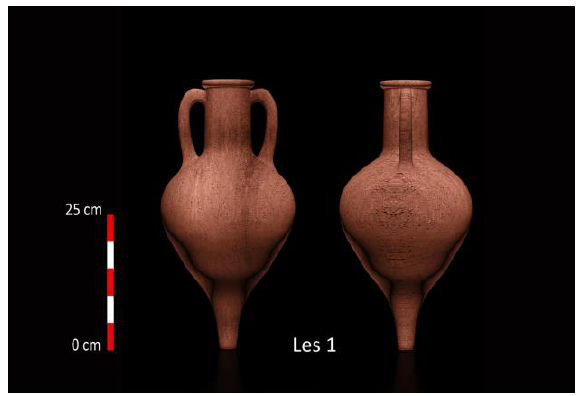
Figure 8. A red Lesbian Amphora which is dated between the last quarter of the 6 th century and the 1 st quarter of the 5 th century.